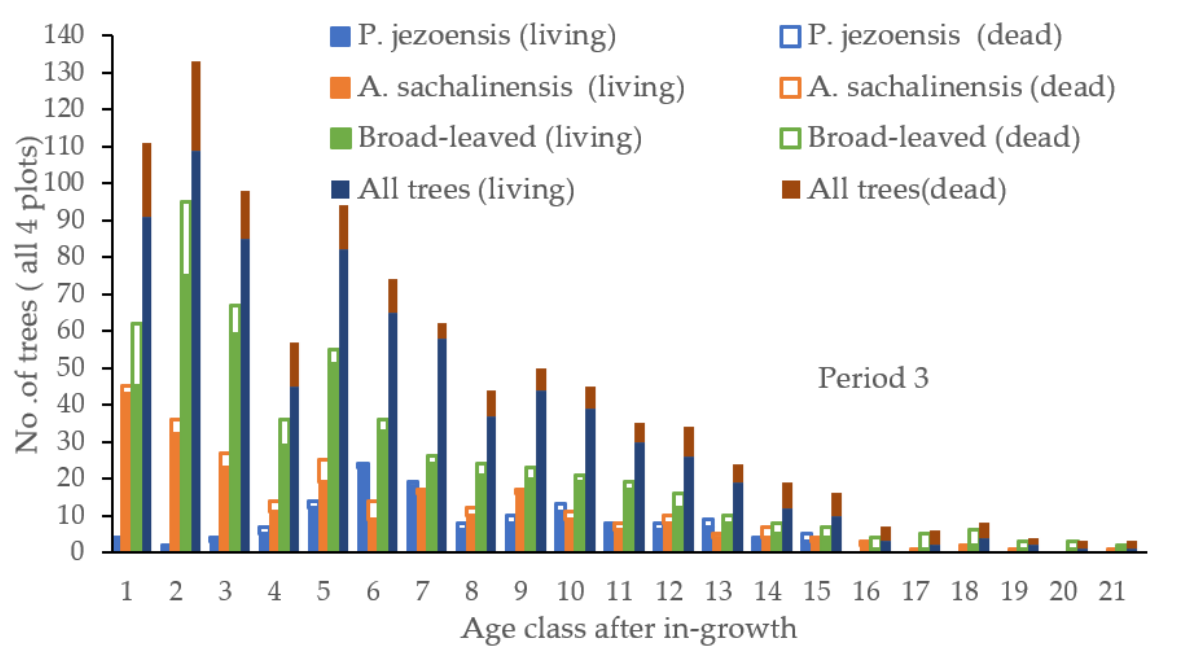
Figure 2. Age ‐ class distributions of living and dead trees of major conifer species, broad ‐ leaved Figure 2. Age-class distributions of living and dead trees of major conifer species, broad-leaved trees, trees, and all the trees of 4 study plots in period 3. and all the trees of 4 study plots in period 3.